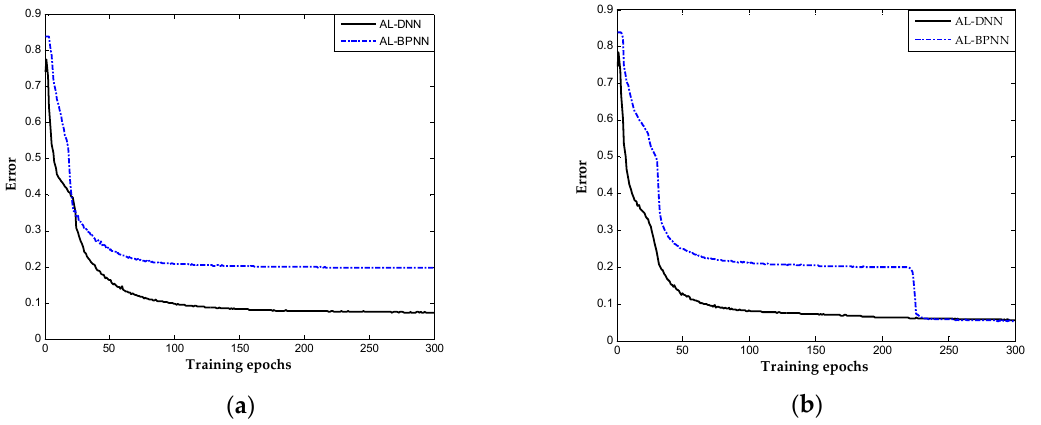
Figure 8. Curves of error of the proposed and AL-BPNN methods: ( a ) the seventh trial of dataset; and ( b ) the ninth trial of dataset.